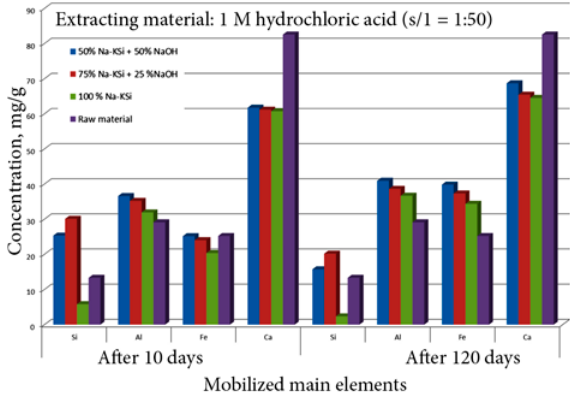
Fig. 10. Quantity of mobilized main elements from geopolymers (at 10 and 120 days age) using different alkaline activator solutions in 1 M hydrochloric acid (solid/liquid ratio